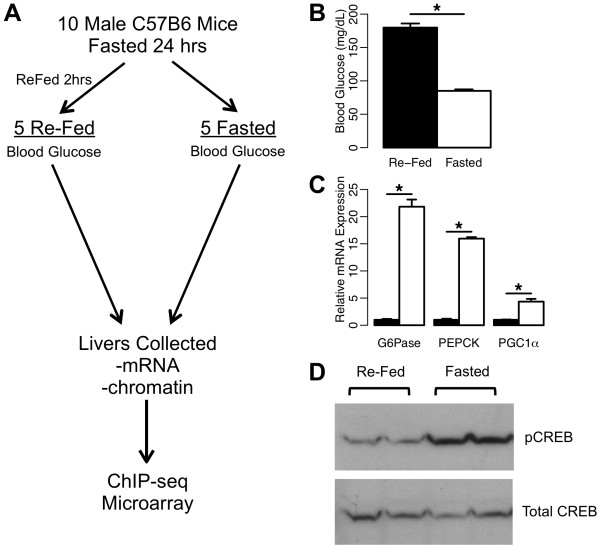
Experimental design and validation. A) Overview of experimental design. A cohort of 10 male C57BL/6J mice was fasted for 24 hours, then split into fasted and re-fed groups (n=5 each). The fasted mice were immediately sacrificed, while the re-fed group was given access to food for 2 hours before sacrificing. Blood glucose measurements were taken from all mice prior to sacrifice. Livers were collected shortly after sacrifice, and used for both mRNA and ChIP-seq experiments. B) Blood glucose was significantly higher in re-fed animals. Error bars indicate SEM, *p < 1E-4, one-tailed Student’s t-test. C) Known fasting-induced gluconeogenic genes are significantly induced in the fasted state (white bars) relative to the re-fed state (black bars) by RT-PCR. Error bars indicate SEM, *p < 0.005, one-tailed Student’s t-test). D) Western blot analysis of mouse livers shows that CREB is strongly phosphorylated on Ser133 after a 24 hr fast, but not after 2 hour re-feeding. Western blot was re-probed with an antibody for total CREB to validate equal loading.